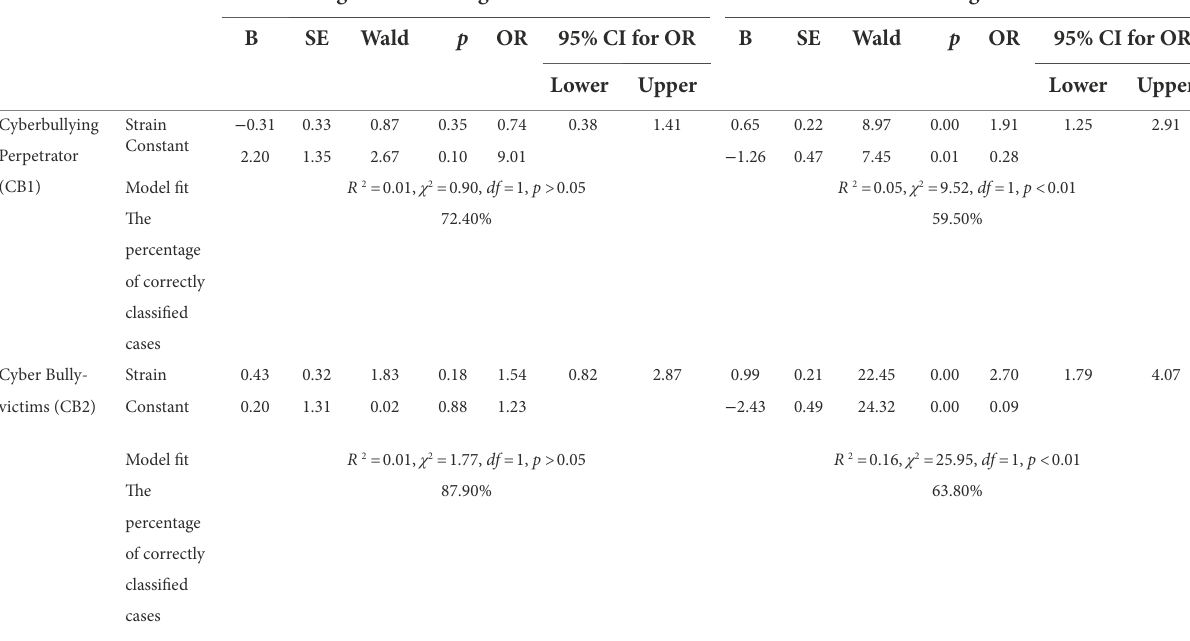
TABLE 1 Results of the binary logistic regression analysis of negative emotion, strain and cyberbullying. Variable